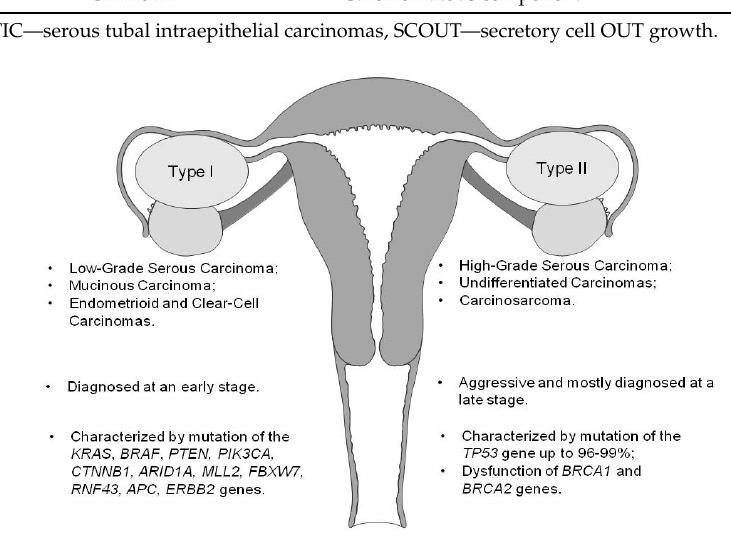
Figure 1. A schematic representation of type I and type II EOC.